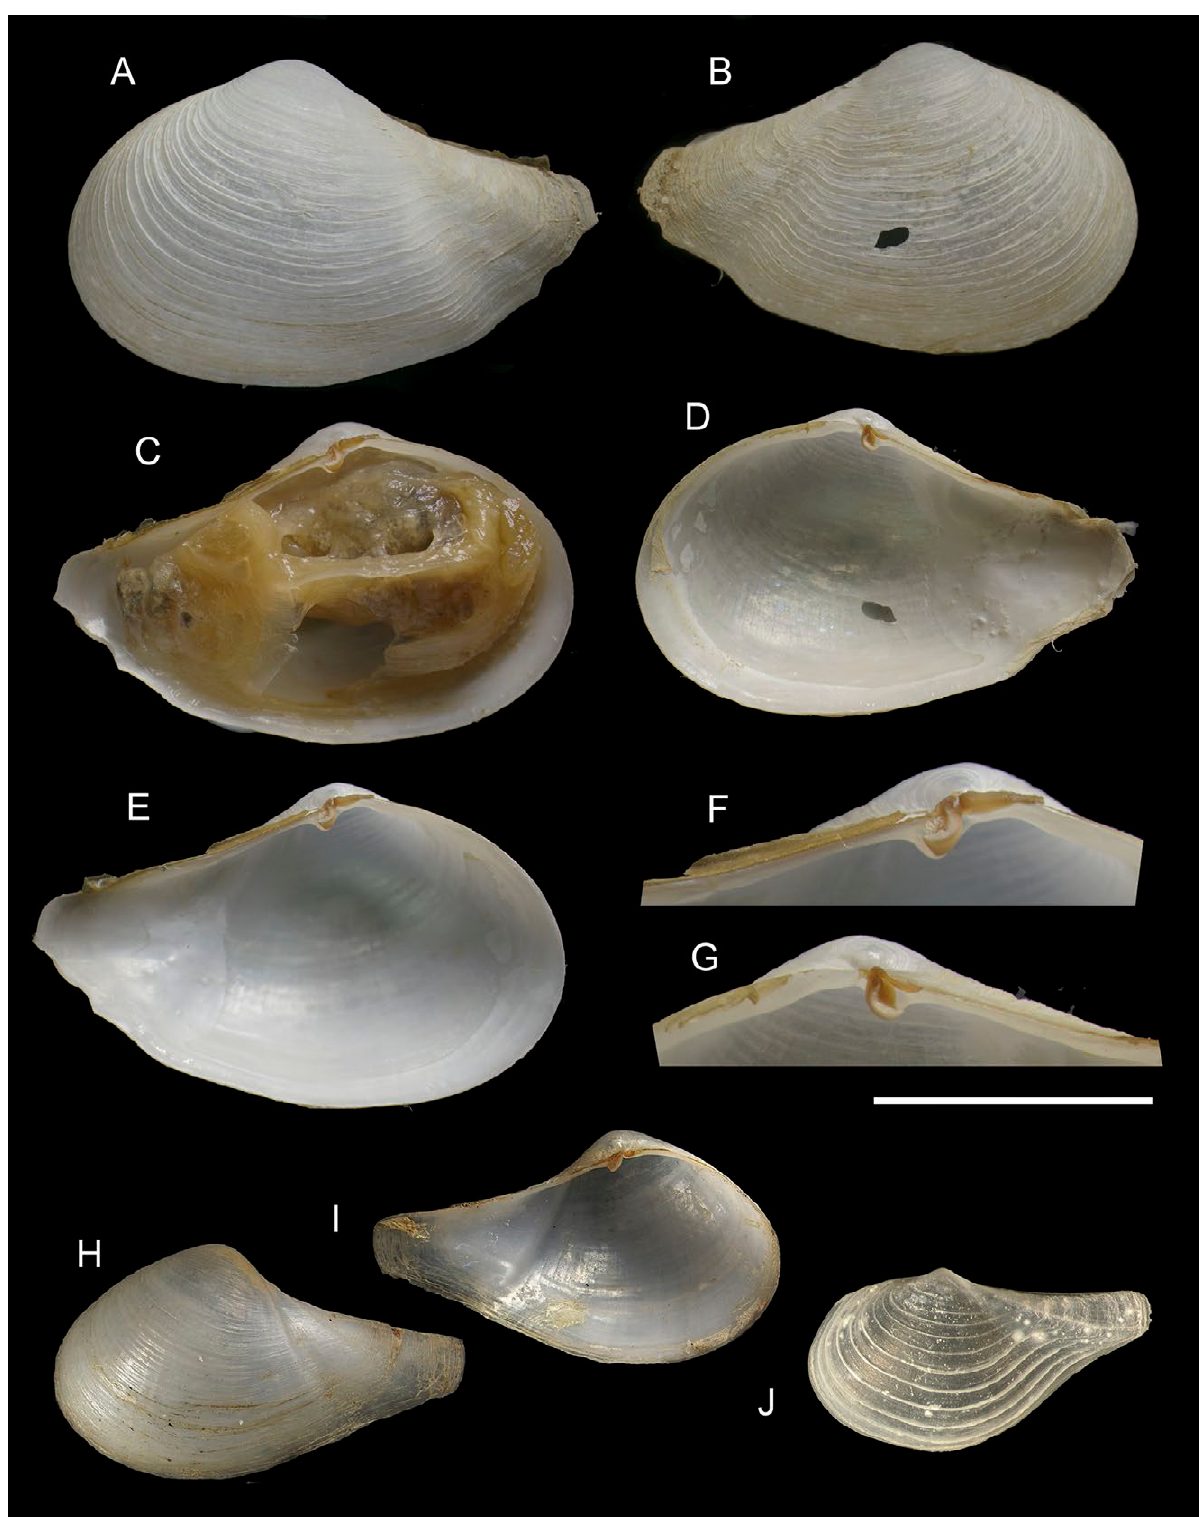
Fig. 6 . – A-G, holotype of Myonera atlasiana n. sp., INDEMARES/CHICA 0610 DA10, 390 m depth (19.0 mm). A-B, external views of the valves; C, internal view of the left valve and the body of the bivalve; D, internal view of the left valve; E, internal view of the right valve; F-G, detail of the hinge (scale bar 5 mm); H-I, Myonera sulcifera (Jeffreys, 1882), external and internal view of left valve, NHM.1888.11.5.1037; ‘Porcupine exp 1869’, S of Ireland, stn. 40, 49°01 ′ N, 12°05 ′ W, 517 m (9.2 mm); J, Myonera alleni Poutiers, 1995, Porcupine abyssal plain, 3900-3950 m (3.6 mm; photos H-J courtesy of National Museum of Wales). DA, benthic ventral moderately curved, posterior dorsal margin length, separated from the rest of the shell by a furrow, nearly right. Rostrum short, about one-third of the shell with a keel separating the rostrum from the furrow and